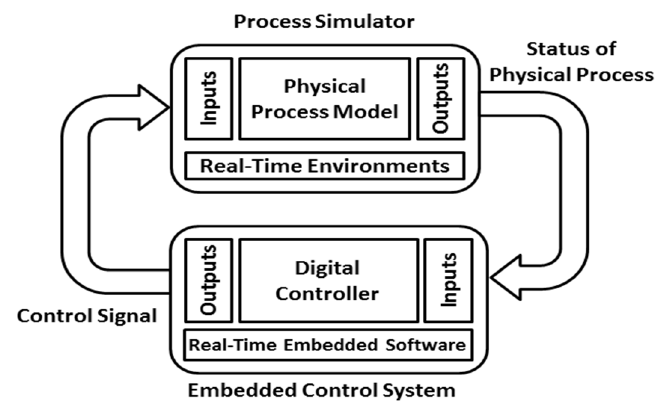
Figure 2. Principle of hardware-in-the-loop (HIL) testing.